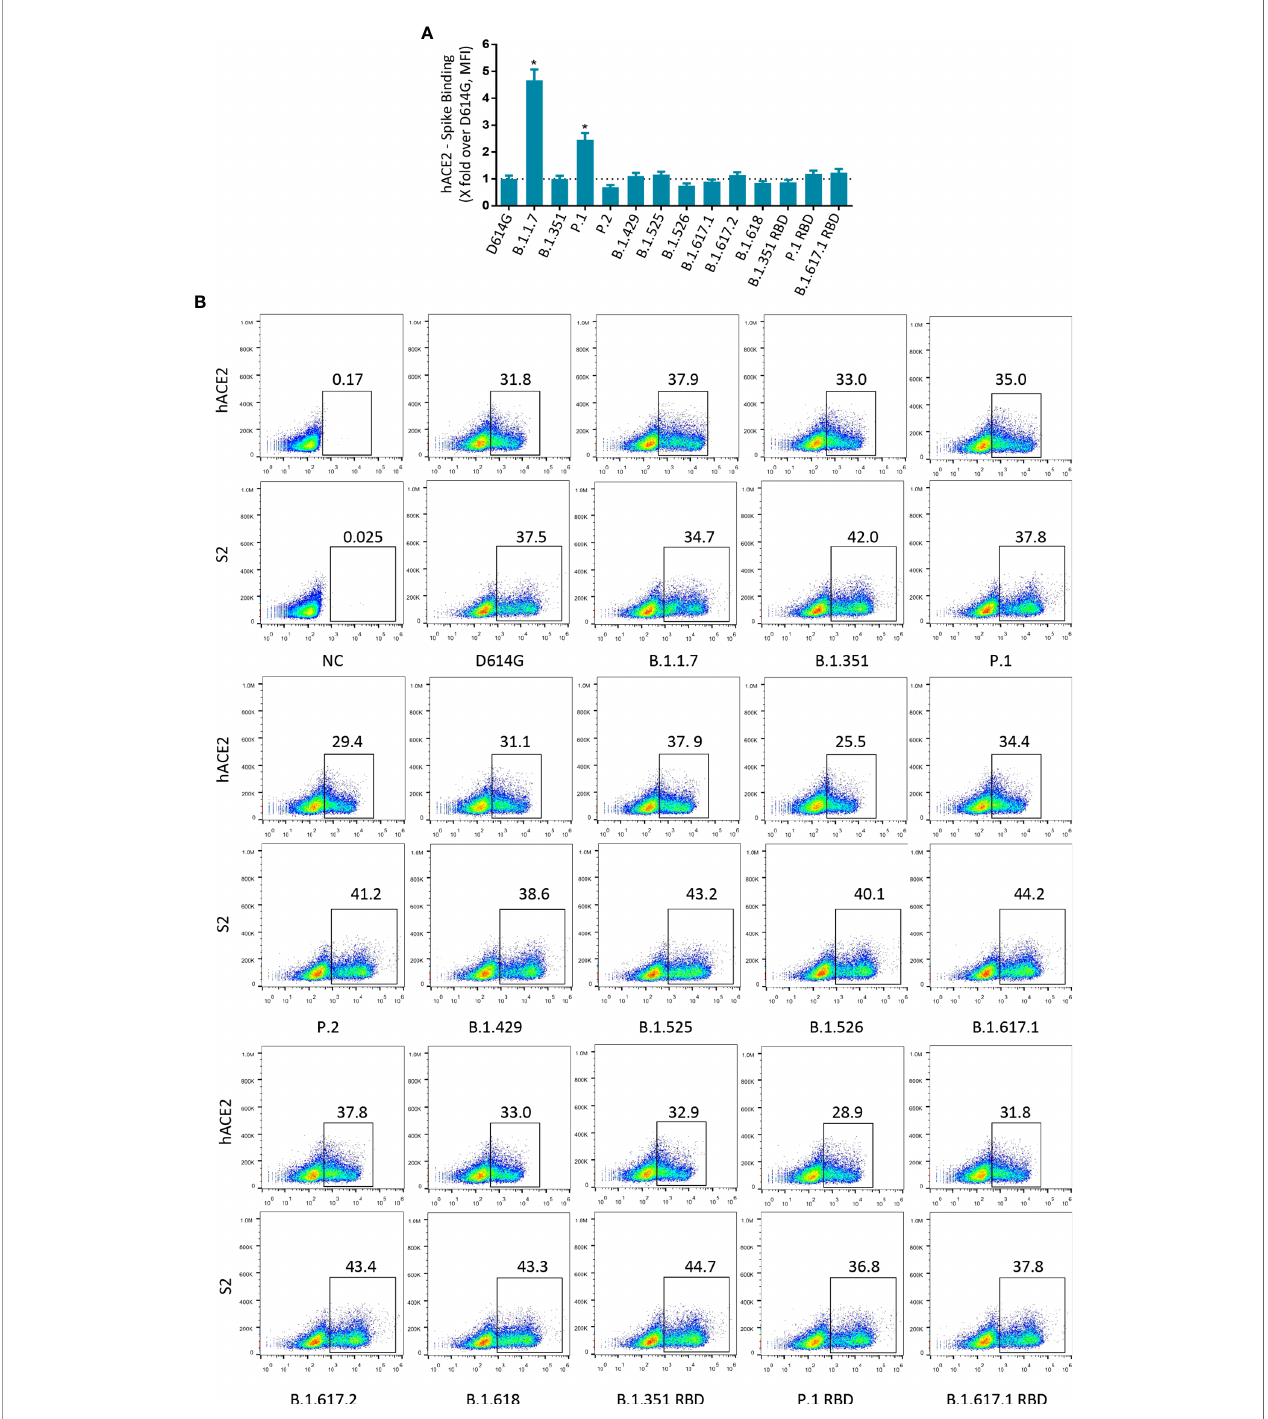
FIGURE 3 | Binding of SARS-CoV-2 variants S protein to recombinant hACE2. (A) The fold changes in binding activity of SARS-CoV-2 variants S protein to recombinant hACE2, measured by mean fl uorescence intensity (MFI). Recombinant hACE2 protein binding percentages were calculated by the ratio between variants over D614G MFI normalized relative to that of S2 speci fi c antibody. All MFI values were weighted by multiplying the number of positive cells in the selected gates. (B) 293T cells transiently expressing SARS-CoV-2 variants S proteins were incubated with recombinant hACE2 protein or anti-SARS-CoV-2 spike (S2 subunit) antibodies for 1 h. After being washed, cells were incubated with Alexa Flour 488-conjugated anti-human IgG Fc or fl uorescein isothiocyanate (FITC)-conjugated anti- mouse IgG secondary antibodies. A p-value less than 0.05 was de fi ned as statistically signi fi cant (p < 0.05 [*]). Experiments were done at least